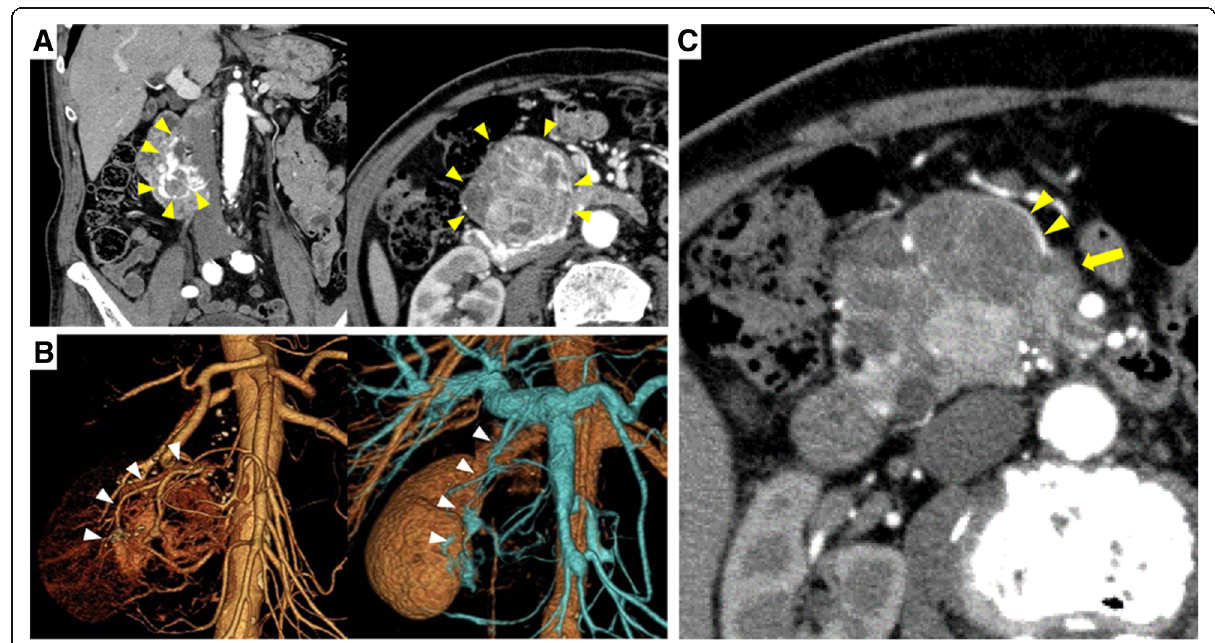
Fig. 1 a Computed tomography (CT) of the serous cystic neoplasm (SCN) with hypervascularity in the pancreatic head and duodenum (arrow heads) during the late arterial phase. b Three-dimensional CT shows abnormal vasculature through the SCN in the arterial and venous phase (arrow heads). c The vein of the abnormal vasculature around the SCN was enhanced in the artery phase (arrow heads). The superior mesenteric vein was not enhanced (arrow)